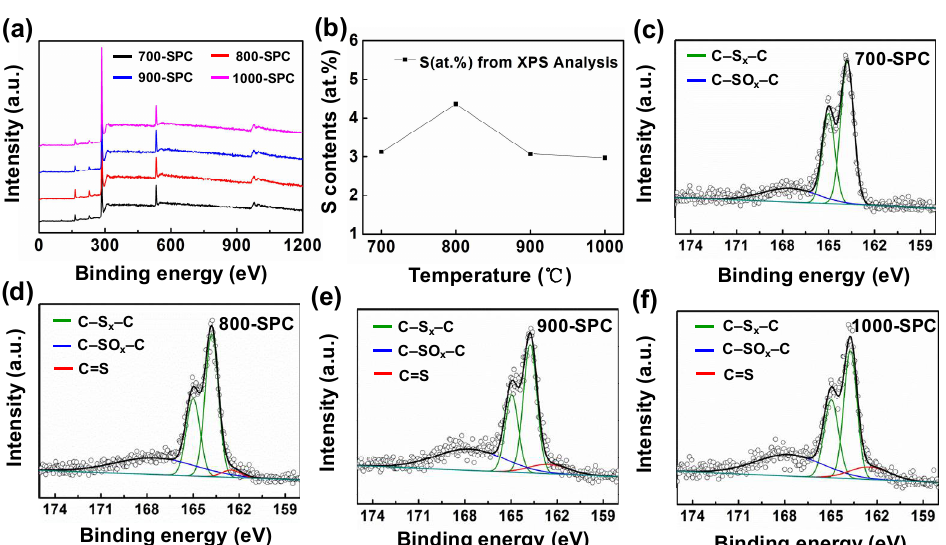
Figure 2. XPS results of SPC materials ( a ). ( b ) are the S contents calculated according to the XPS results. ( c – f ) are the fitting results of SPC materials.